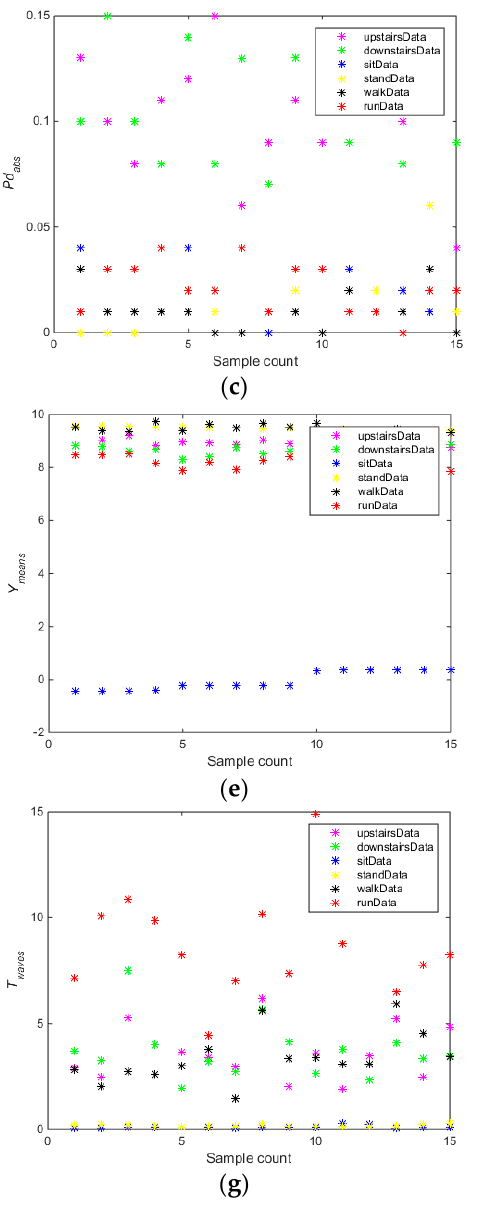
Figure 4. ( a ) d P value; ( b ) results of k -means clustering of d P feature; ( c ) abs d P value; ( d ) results of k -means clustering of abs d P feature; ( e ) means Y value; ( f ) results of k -means clustering of means Y k -means clustering of P d feature; ( e ) Y means value; ( f ) results of k -means clustering of Y means feature; abs feature; ( g ) waves T value; ( h ) results of k -means clustering of waves T feature. ( g ) T waves value; ( h ) results of k -means clustering of T waves